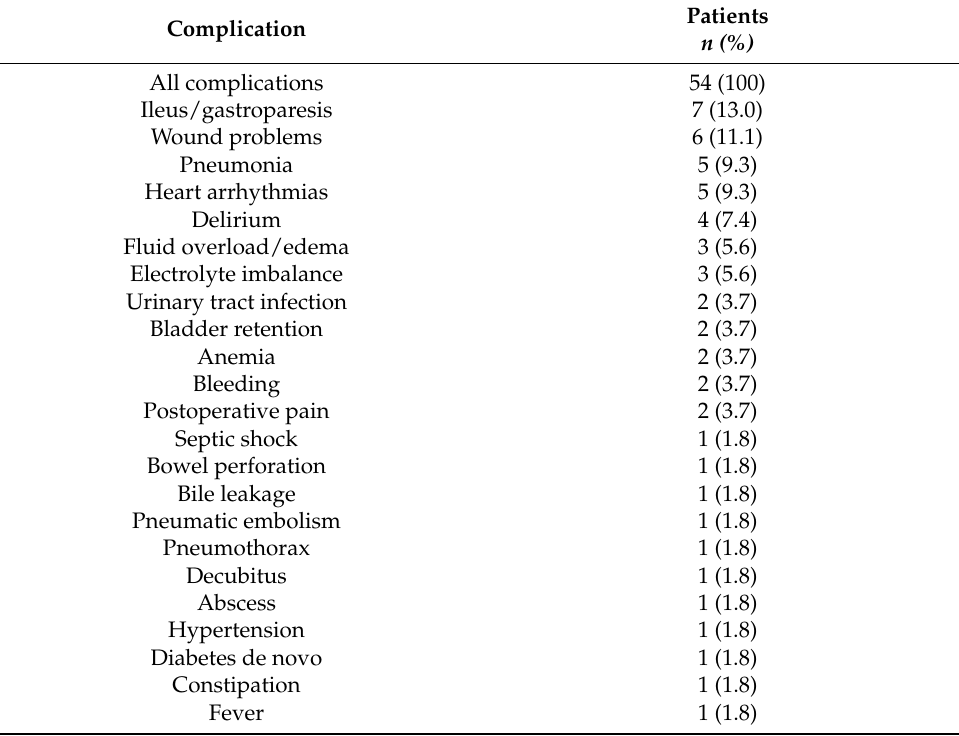
Table 4. Description of complications observed in patients after metastatic adrenalectomy.